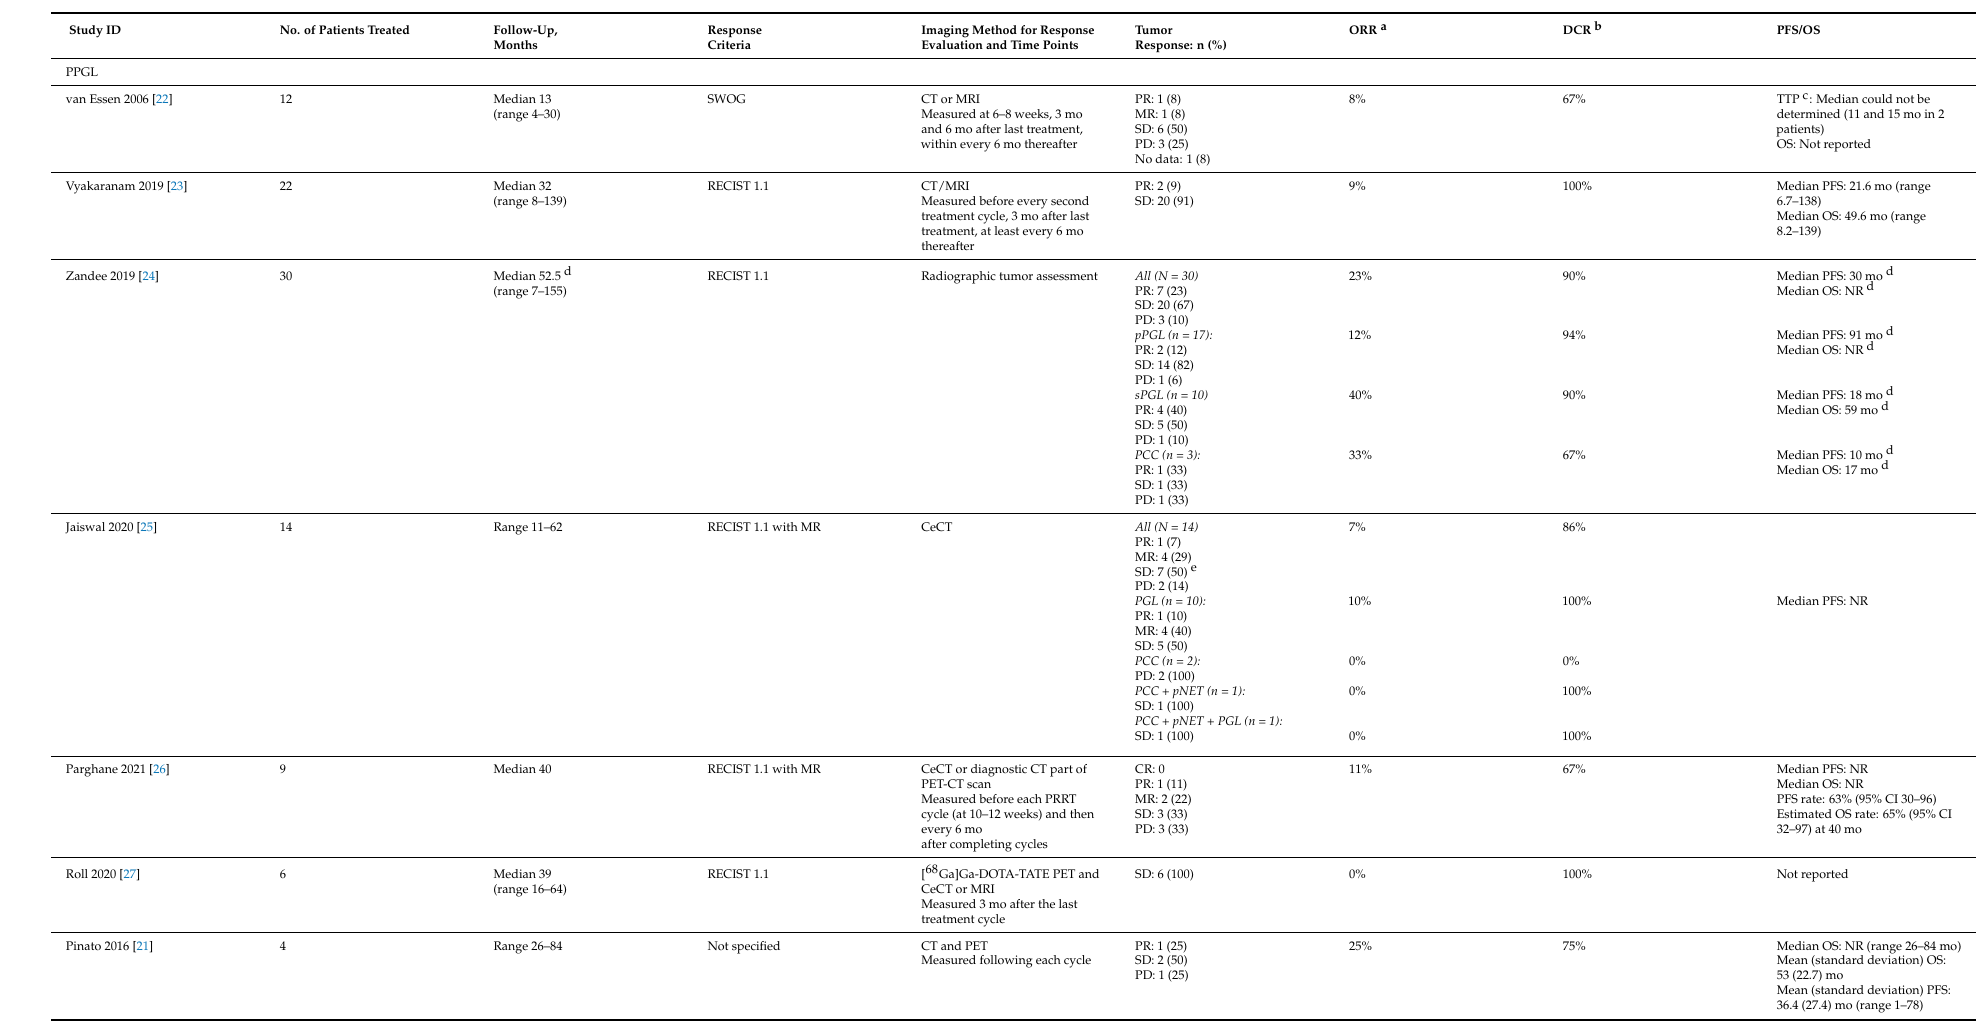
Table 2. Study evaluation and outcomes of included